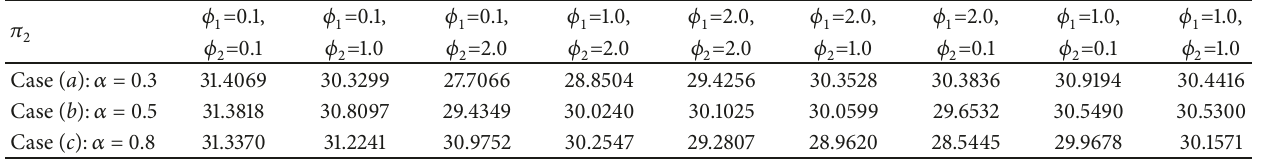
Table 4: The impact of fairness concern on player 2’s expected profit 𝜋 2 under three